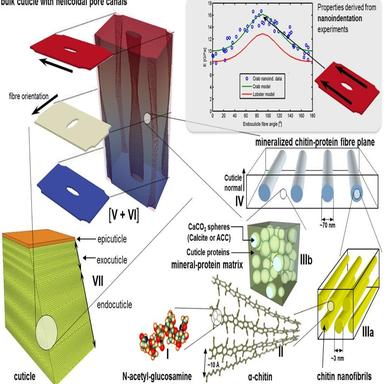
Multi-scale hierarchical modeling of crustacean cuticle showing the Representative Volume Elements (RVEs) used at different length scales. The properties of α-chitin (I and II) and the calcite mineral phase (IIIb) were obtained from ab initio calculations using Molecular Dynamics (MD), Tight Binding (TB) and Density Functional Theory (DFT). Their elastic constants are introduced into a continuum-scale model of the chitin nanofibrils (IIIa), which are represented as rods, and a protein/mineral matrix (IIIb)